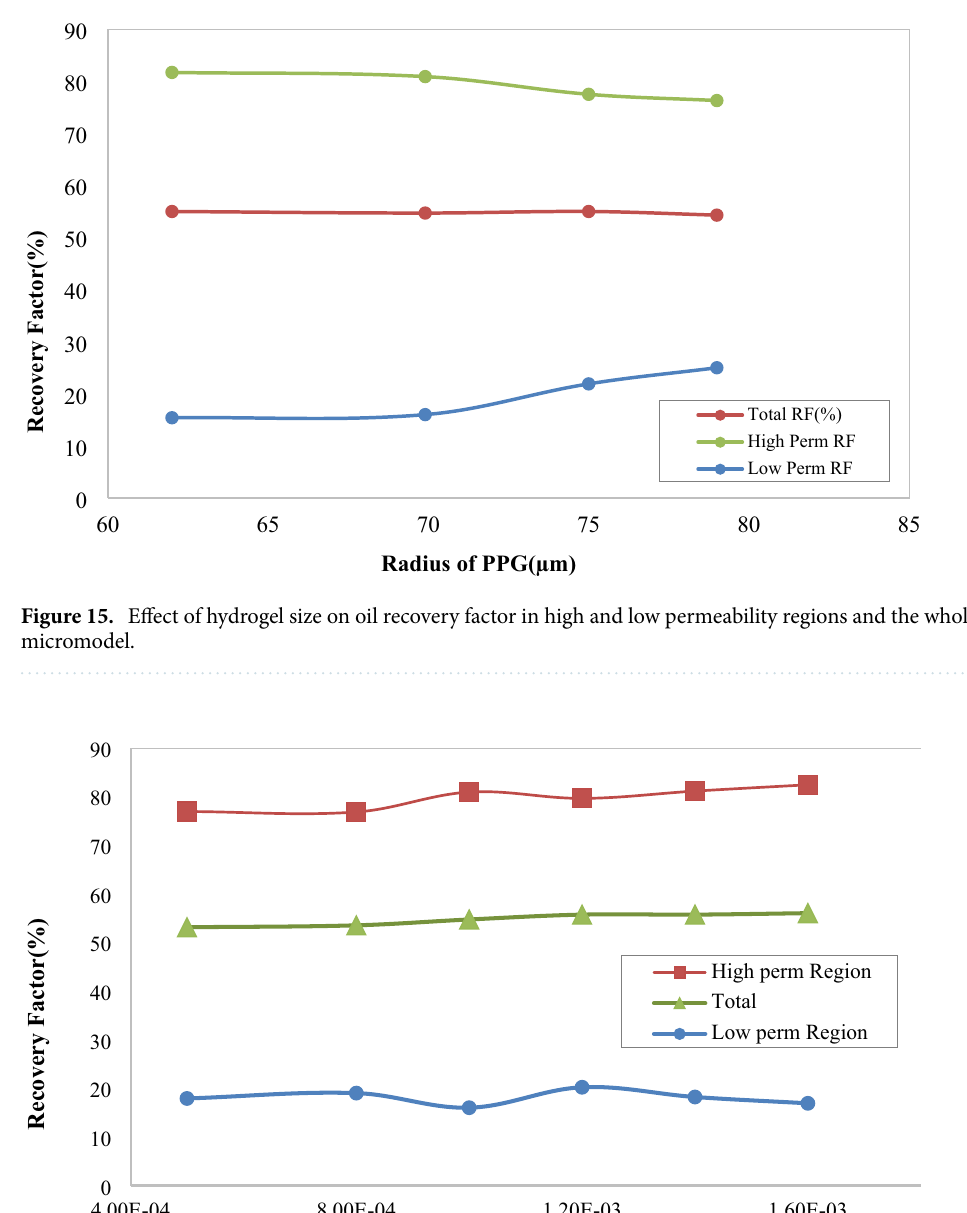
Fig. 18 (path 1). Moreover, hydrogels are accumulated at inlet of high permeability region which steers the flow to low permeability area (path 2). With increasing the viscosity of hydrogel particles, the penetration and place- ment of the particles in high permeability region is reduced. This leads to reducing the oil recovery factor, since hydrogels are unable to direct the flow to low permeability area. Statistical model for hydrogel injection. In this section, a statistical model is represented to determine oil recov- ery factor in hydrogel injection process. This model was proposed based on the effective parameters including, fluid injection rate, hydrogel size and viscosity of hydrogel solution. The results of ANOVA analysis for the high permeability region is represented in Table 7. F-values and P-values represent that the model is significant. The proposed model is represented in Eq. (17).